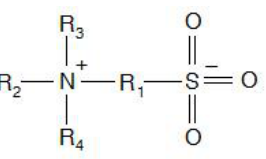
Figure 1. Sulfobetaine functional